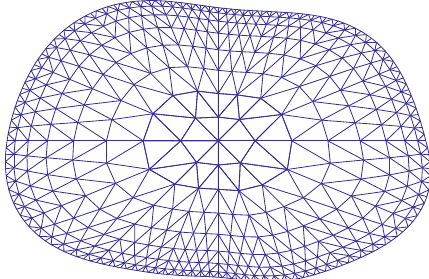
Figure 1: Schematic diagram of the FEM for